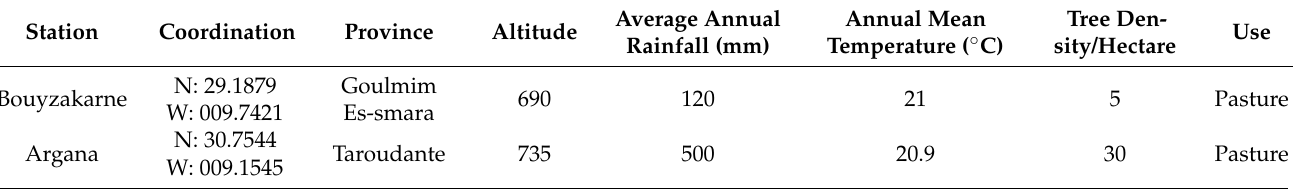
Table 1. Ecological Characteristics of Inoculum Source